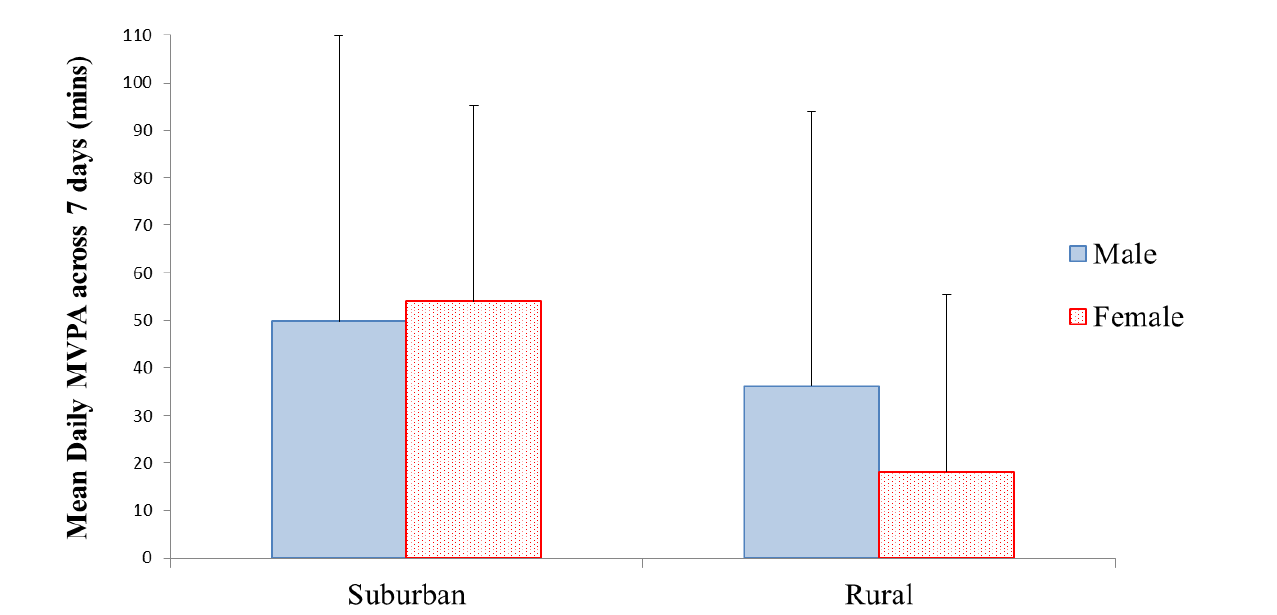
Figure 1. Mean (±SD) daily PA of rural and suburban youth across the 7